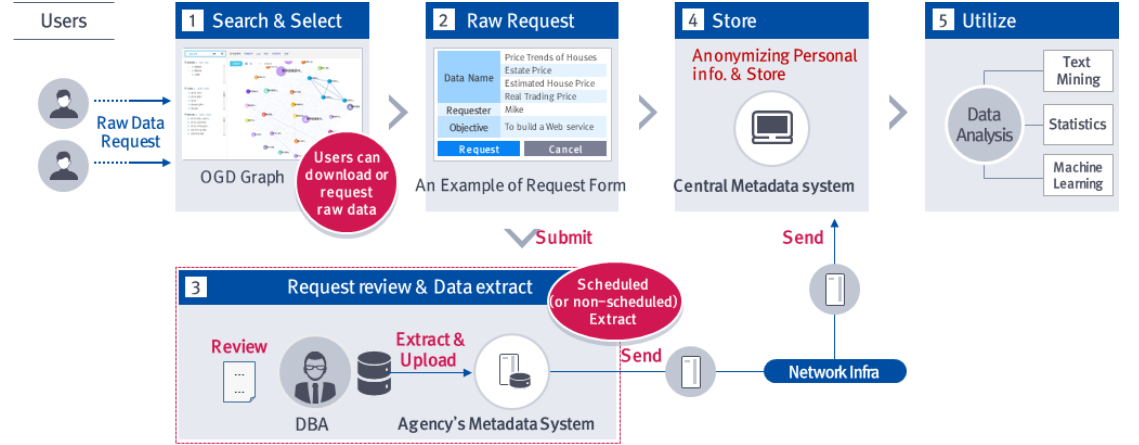
Figure 7. Raw Data Request and Delivery